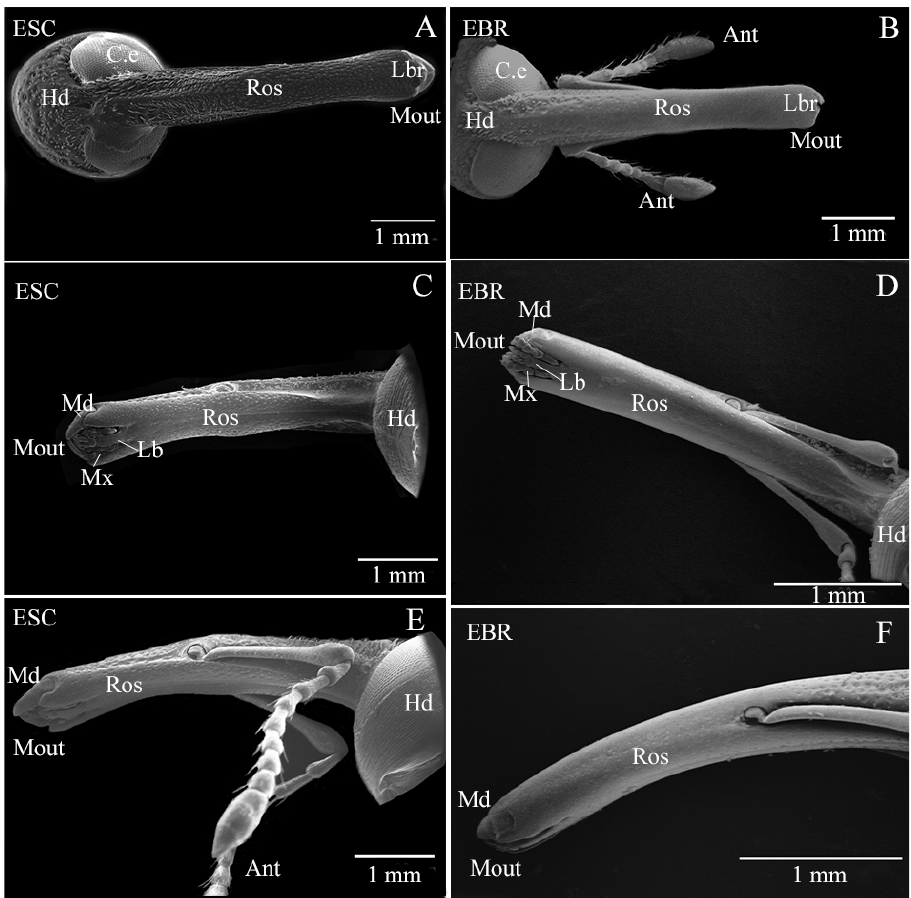
Figure 1. Scanning electron micrographs showing the overall appearance of Eucryptorrhynchus scrobiculatus (ESC) and E. brandti (EBR) rostrum. ( A , C , E ) the overall appearance of E. scrobiculatus rostrum (the dorsal view, the ventral view and the lateral view, respectively); ( B , D , F ) the overall appearance of E. brandti rostrum (the dorsal view, the ventral view and the lateral view, respectively). Hd, Head; C.e, Compound eyes; Ros, Rostrum; Ant, Antenna; Mout, Mouthpart; Lbr, Labrum; Md, Mandible; Mx, Maxillae; Lab, Labium.